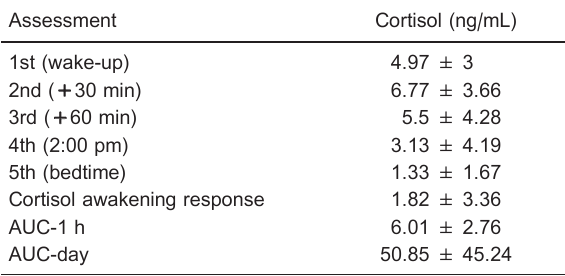
Table 2. Cortisol values observed for 102 patients with